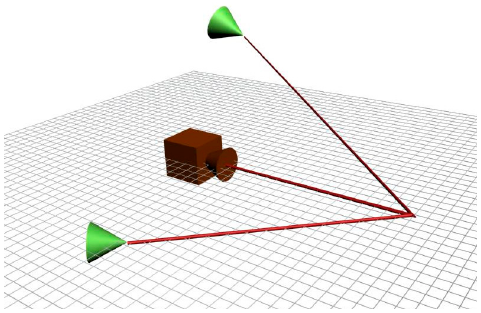
Figure 1. Sketch of the laser projectors and camera (VISSCAN-3D).